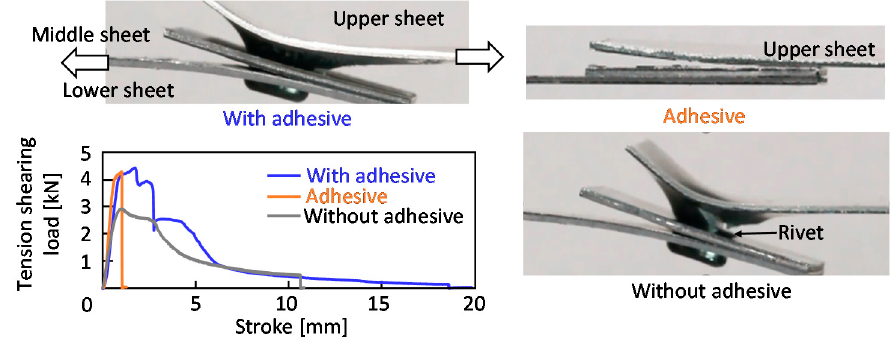
Figure 28. Tension-shearing load and stroke curves of upper-lower sheets for self-pierce riveted sheets, D = 8 mm, H = 1.8 mm and L = 5 mm.